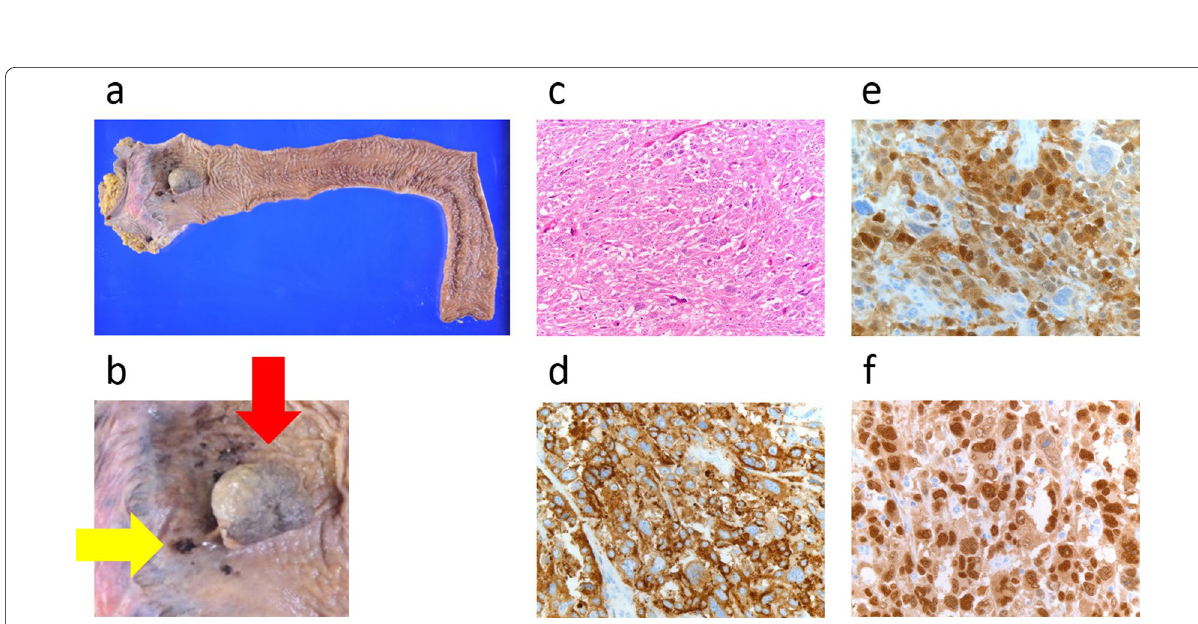
Fig. 2 Macroscopic findings, histopathological findings, and immunostaining findings of ARMM. a , b Pathological specimens revealed a semi-pedunculated tumor 30 mm in size in the anal canal and peripheral discontinuous melanin depositions. c Histopathological findings demonstrated diffuse proliferation of atypical cells with prominent nuclei of varying size accompanied by melanin depositions. d Positive for HMB-45. e Positive for S-100. f Positive for